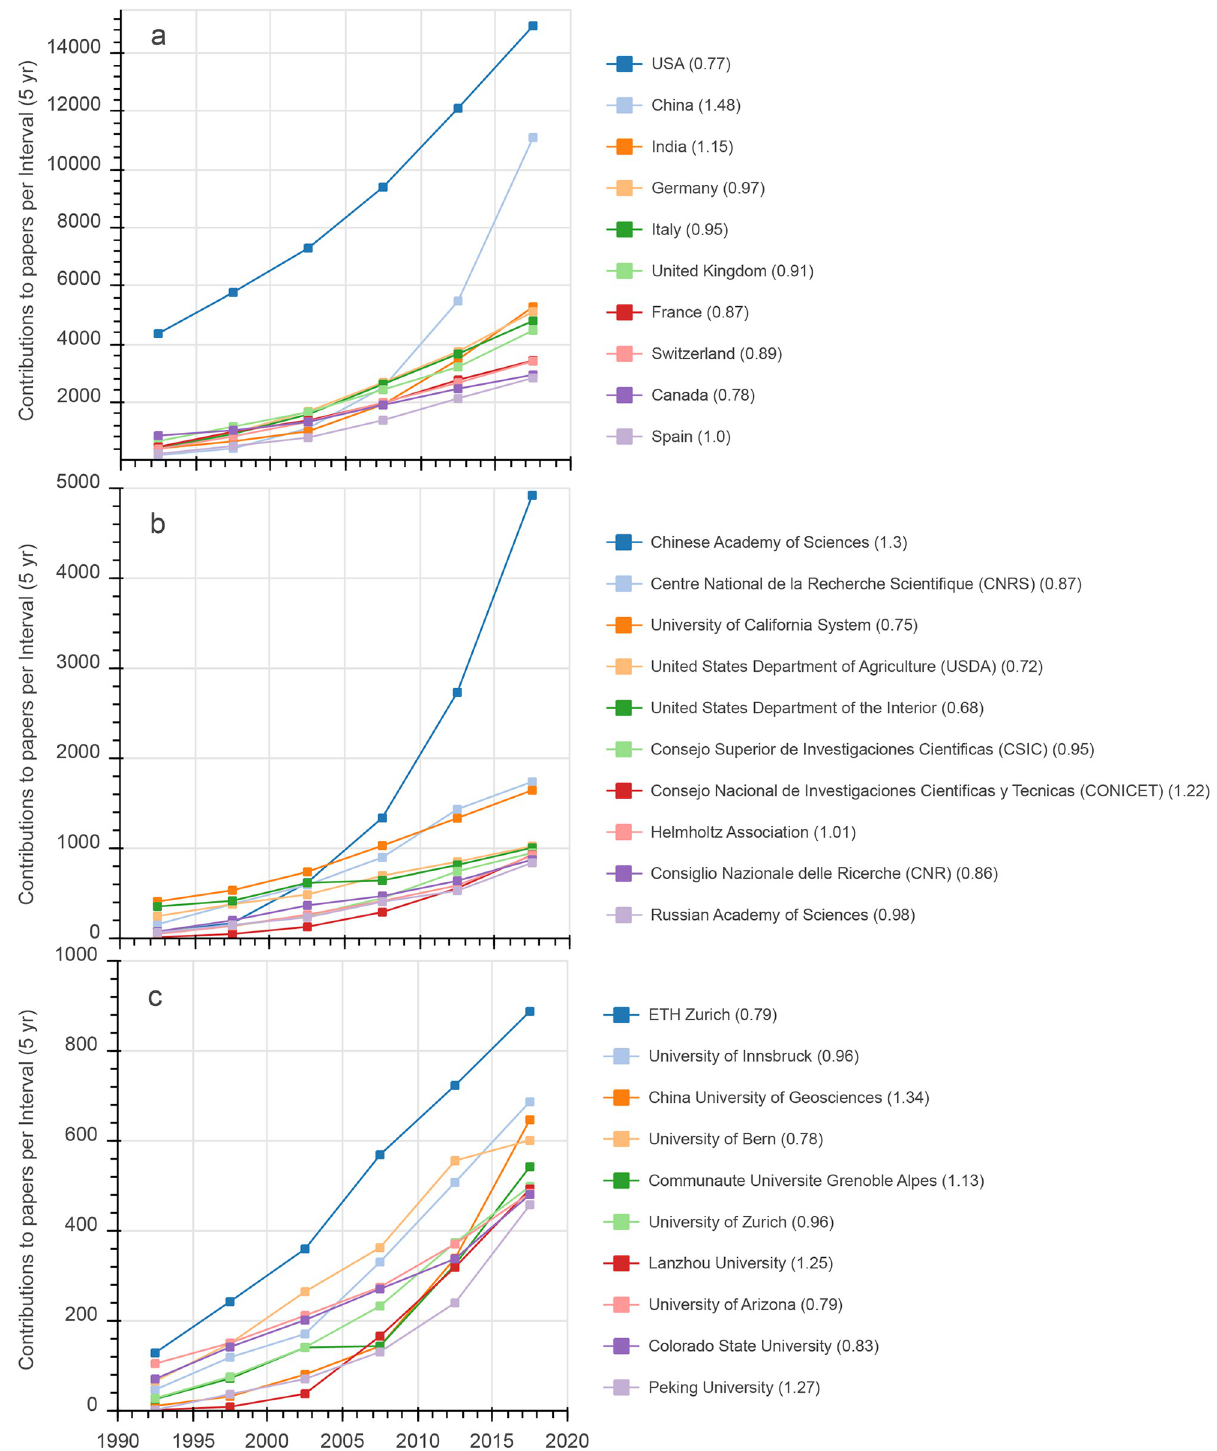
Fig 6. (a) Top 10 Country contributions to papers for 5-year intervals from 1990–2019. Paper contributions of (b) Top 10 umbrella-like and (c) Top 10 individual-like organizations for 5-year intervals from 1990–2019. Number in brackets are the Trend Index values (see Eq 1) for